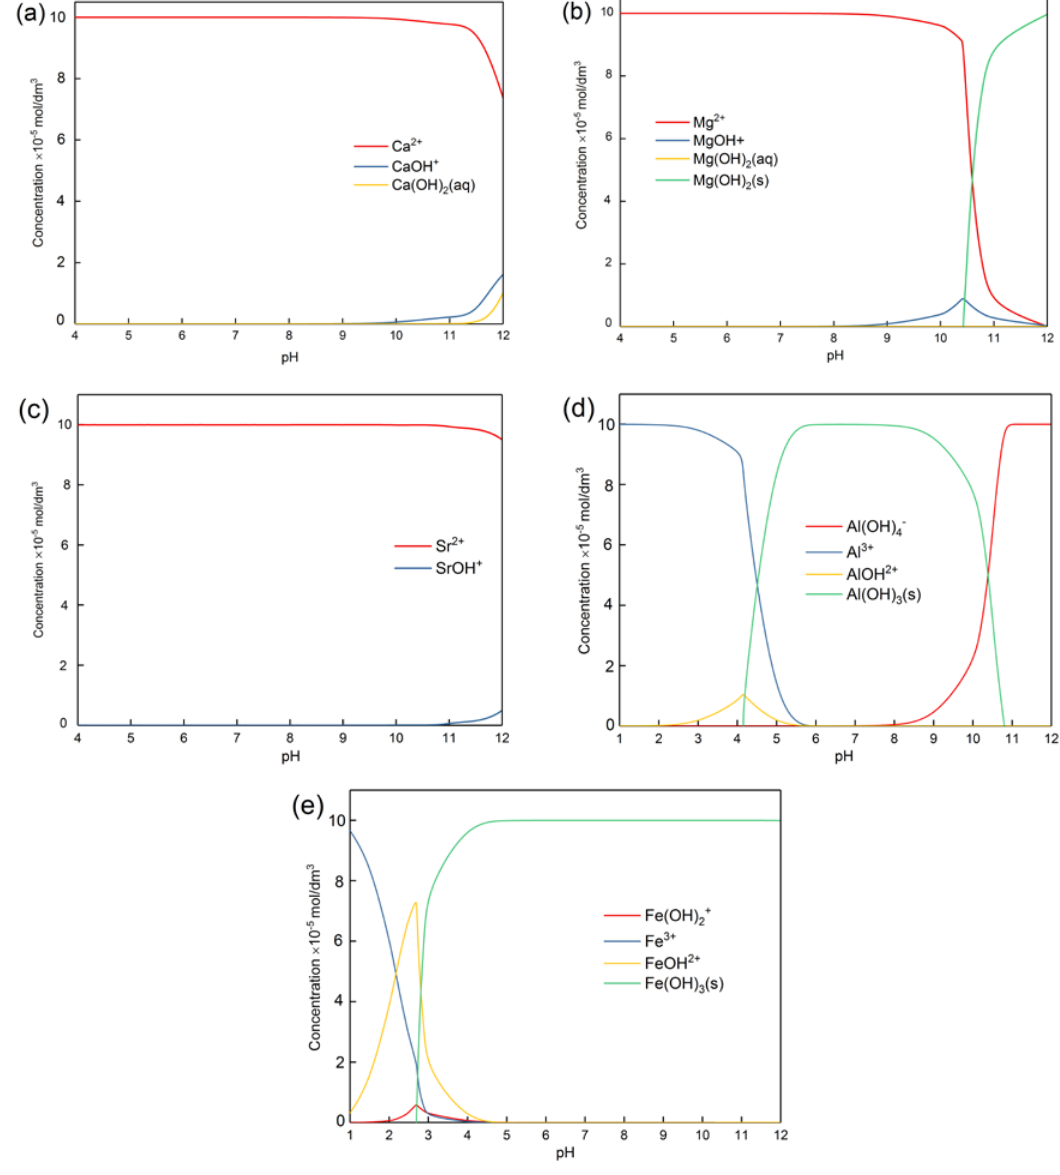
Figure 10. Distribution diagrams of ( a ) Ca 2+ ; ( b ) Mg 2+ ; ( c ) Sr 2+ ; ( d ) Al 3+ ; ( e ) Fe 3+ as a function of pH (1 × 10 − 4 mol/dm 3 ).